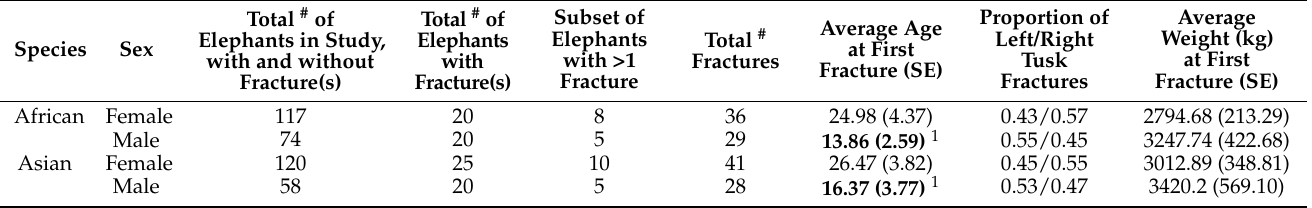
Table 1. Tusk fracture prevalence, incidence and individual level traits within study